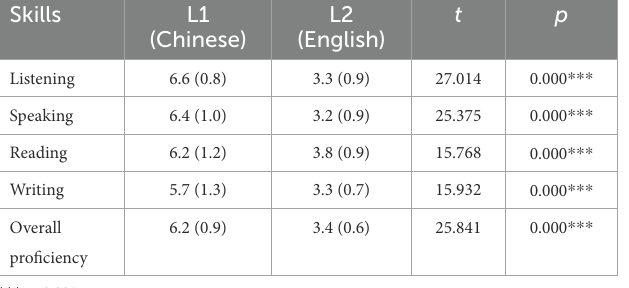
TABLE 1 Means and SDs of the proficiency ratings for four skills of Chinese and English. Skills